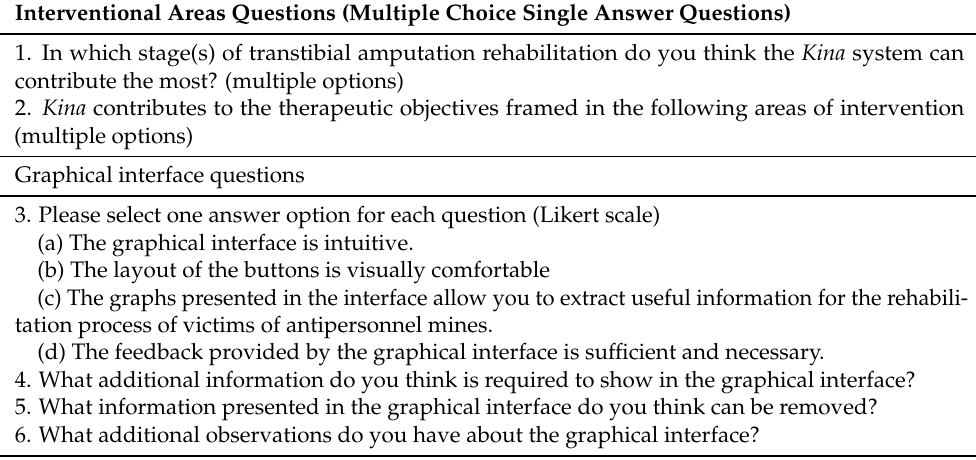
Table 3. Questions about intervention areas and graphical interface.